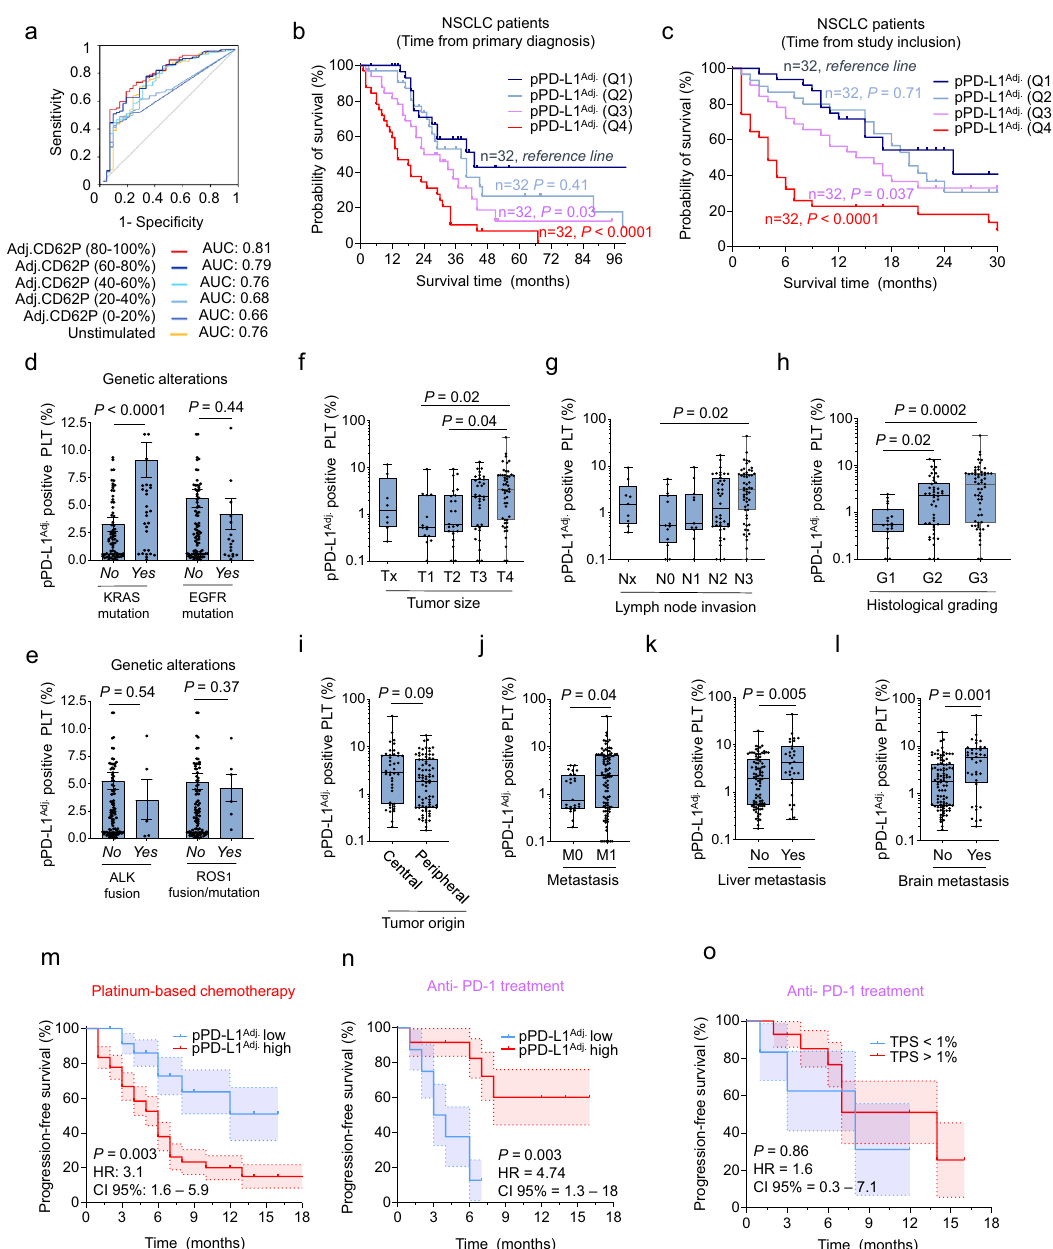
Fig. 7 Platelet-derived PD-L1 (pPD-L1) as prognostic and predictive marker in NSCLC. a Combined estimate of platelet CD62P (0 – 100%) and pPD-L1 levels predicts overall survival (OS) in 128 NSCLC patients; receiver-operating characteristics (ROC) analysis. b Kaplan – Meier analysis of overall survival (OS) dependent on the pPD-L1 Adj as de fi ned by quartile groups (very low (Q1), low (Q2), high (Q3) and very high (Q4)). Survival data refer to the time point of primary diagnosis ( n = 128). c Overall survival (OS) in different pPD-L1 Adj quartile groups according to the time point of platelet analysis ( n = 128). b , c Statistical signi fi cance was calculated by log-rank test. d , e Association of pPD-L1 Adj levels and different genetic alterations (KRAS (mut = 38, wt = 90), EGFR (mut = 19, wt = 109), EML-4-ALK (alteration = 5, no alteration = 123) and ROS-1 (alteration = 6, no alteration 122)) (wt = wildtype, mut = mutation). Data are mean ± SEM. Statistical signi fi cance was calculated by two-tailed Mann – Whitney test. f – h pPD-L1 Adj levels in patients with different tumor stage ((f), Tx = 8, T1 = 14, T2 = 23, T3 = 33, T4 = 50), lymph node invasion (( g ), Nx = 9, N0 = 13, N1 = 11, N2 = 40, N3 = 55), and grade (( h ), G1 = 19, G2 = 48, G3 = 61). Each dot represents a single patient. Statistical signi fi cance was calculated by Kruskal – Wallis test and Dunn ’ s multiple comparisons test. i Association of pPD-L1 Adj levels with tumor origin (central = 42, peripheral = 79). j – l pPD-L1 Adj is associated with the occurrence of metastasis (in general (( j ), M0 = 25, M1 = 103) and at speci fi c sites, including liver (con fi rmed = 31, no metastasis = 94) and brain (con fi rmed = 37, no metastasis = 91). f – l Each dot represents a single patient. Boxes represent median and 25th to 75th percentiles, whiskers are minimum to maximum. Statistical signi fi cance was calculated by two-tailed Mann – Whitney test. m Kaplan – Meier curves estimates of PFS in patients with a pPD-L1 Adj level > median (red) and pPD-L1 Adj level < median (blue) treated with conventional chemotherapy ( n = 62). n Kaplan – Meier curves estimates of PFS in patients with a pPD-L1 Adj level > median (red) and pPD-L1 Adj level < median (blue) treated with anti-PD-1 therapy ( n = 20). o Kaplan – Meier curves estimates of PFS in patients with a TPS score > 1% (red) and TPS < 1% (blue) treated with anti-PD-1 therapy ( n = 20). m – o Statistical signi fi cance was calculated by log-rank test. Source data are provided as a Source Data fi